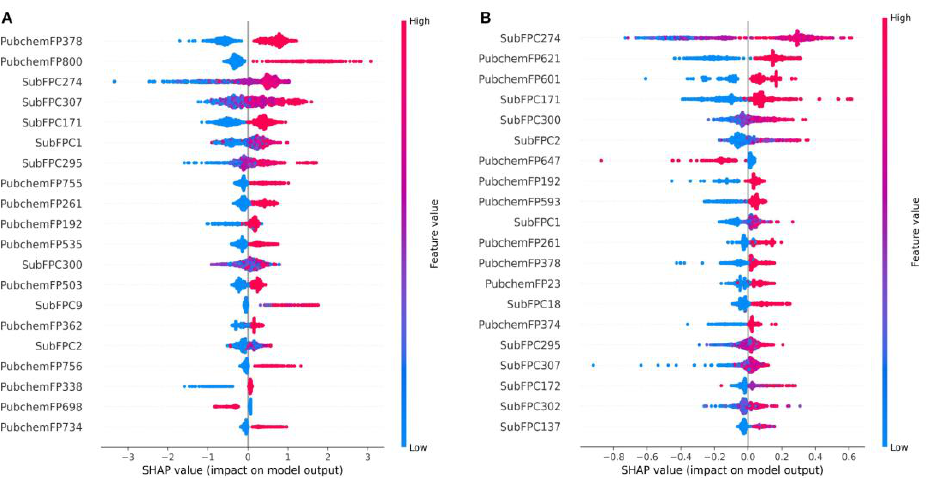
Figure 4. Importance features extracted from machine learning models by using the SHAP algorithm. ( A ) SHAP importance features of the classification XGBoost model and ( B ) SHAP importance features of the regression XGBoost model. The red and blue colors indicate the high and low fingerprint values, respectively.